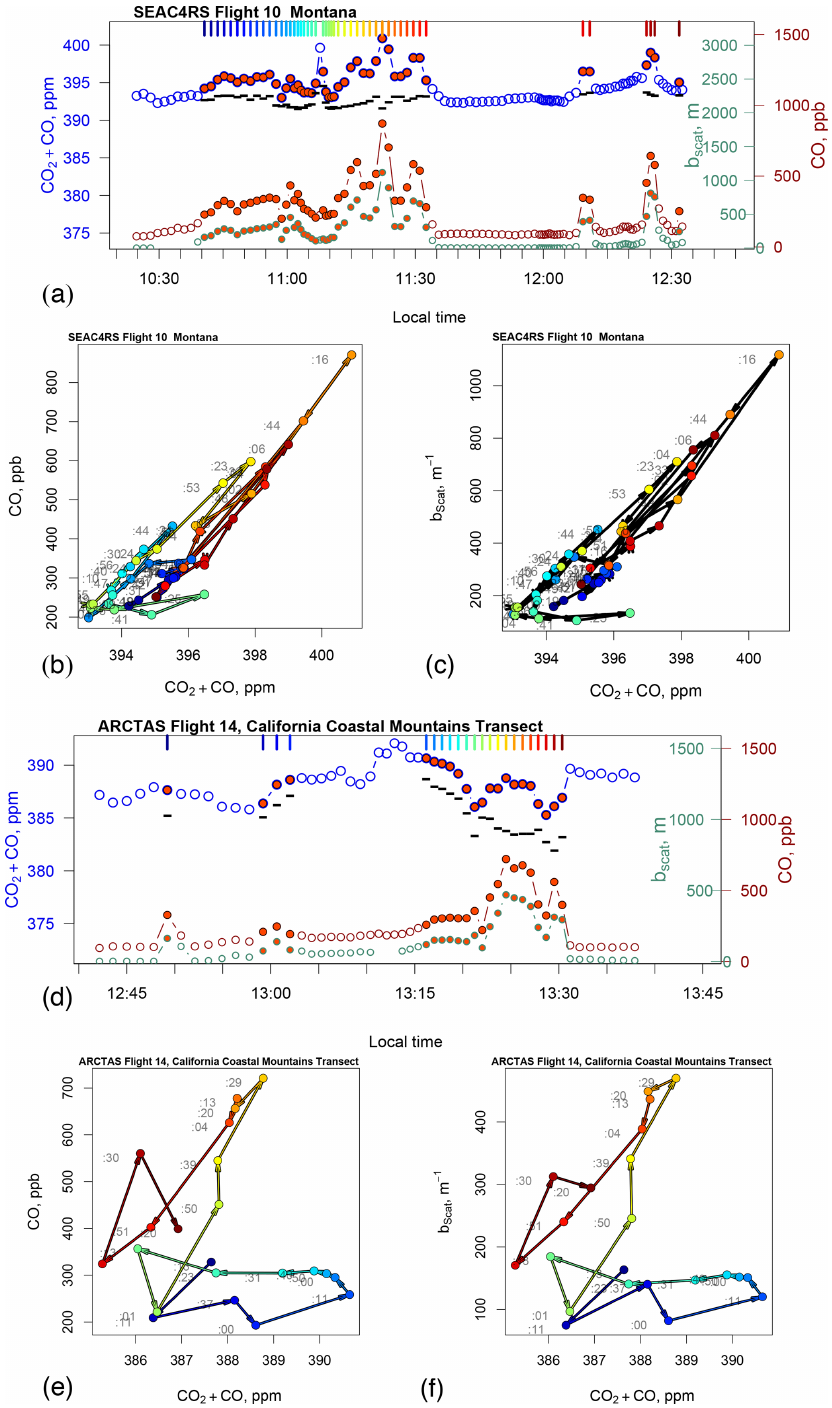
Figure 4. (a) Timeline of sampling, for the period shown in Fig. 3a, Montana, of CO 2 + CO (blue, left axis) and the fire tracers CO and b scat (red and green points, right axis). Orange-filled points were identified as clear plume points. Unfilled points were not identified as such but might have some fire influence, especially near plume points. (b) Scatter diagram of CO vs. CO 2 + CO with arrows showing the time progression of aircraft sampling of identified plume points. Colors provide a key to times shown in panel (a) . Light gray numerals give observation times in minutes. (c) A similar diagram of b scat vs. CO 2 + CO. Similar shapes of figures are noted in the text. (d) Timeline of sampling for the period shown in Fig. 3b, coastal transect. (e) Scatter diagram of CO vs. CO 2 + CO during the transect, like in panel (b) . (f) A similar diagram of b scat vs. CO 2 + CO for the coastal transect. The black bars graphed in panels (a) and (d) are estimates of nonfire- influenced C bkgd ; see text. They and the nonplume points suggest air mass changes in CO 2 +